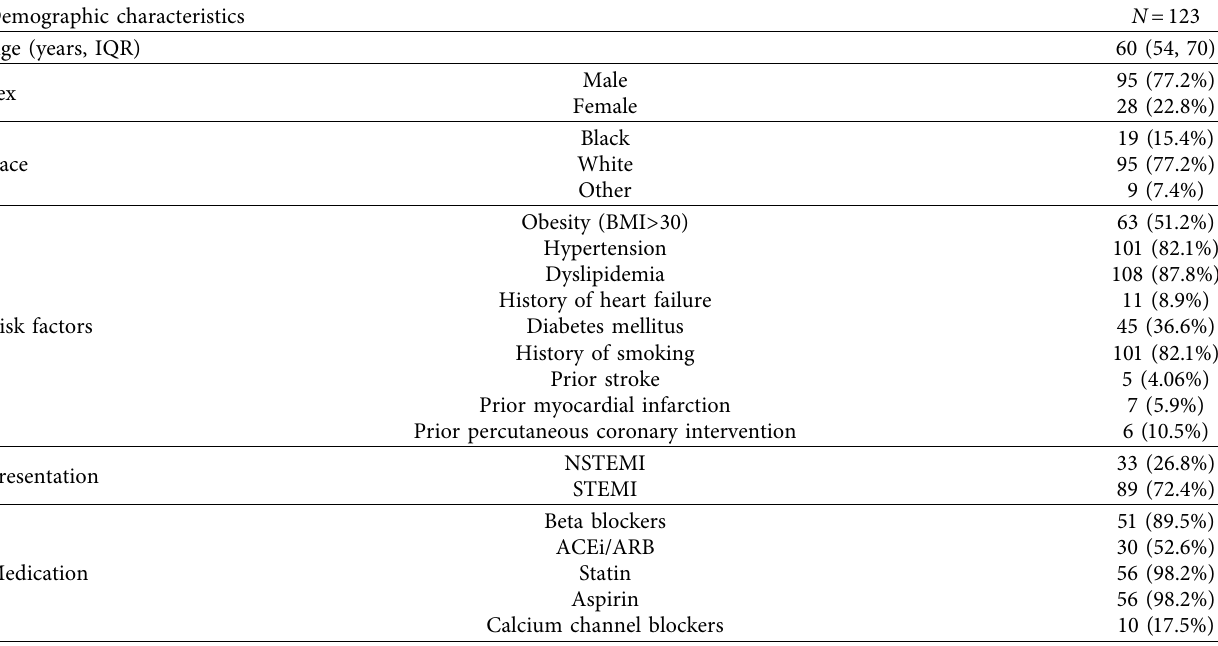
Figure 2: Case 2: 55-year-old male presenting late after anterior STEMI. STEMI, ST segment elevation myocardial infarction. Table 1: Baseline characteristics of patients.